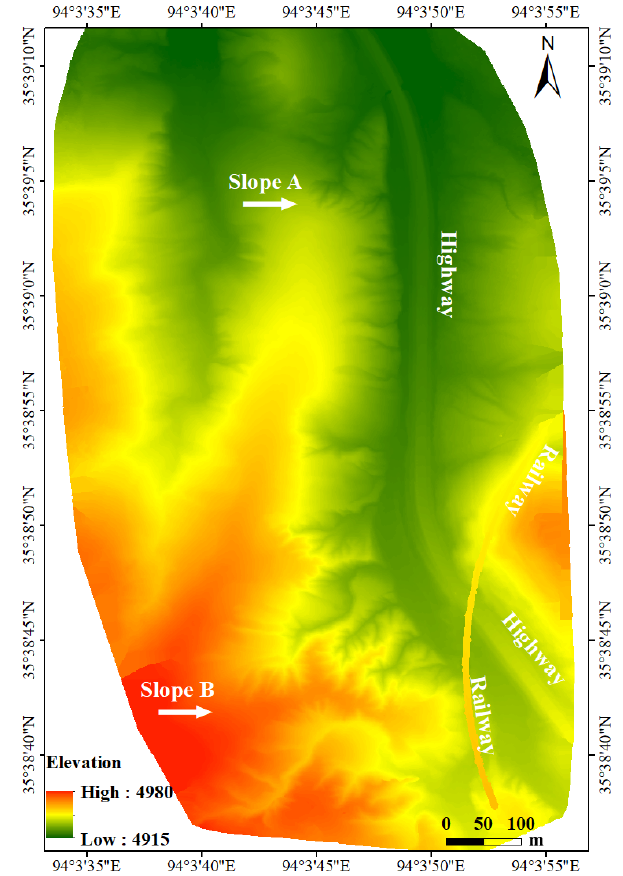
Figure E1. DSM by the UAV: (a) slope A and (b) slope B.